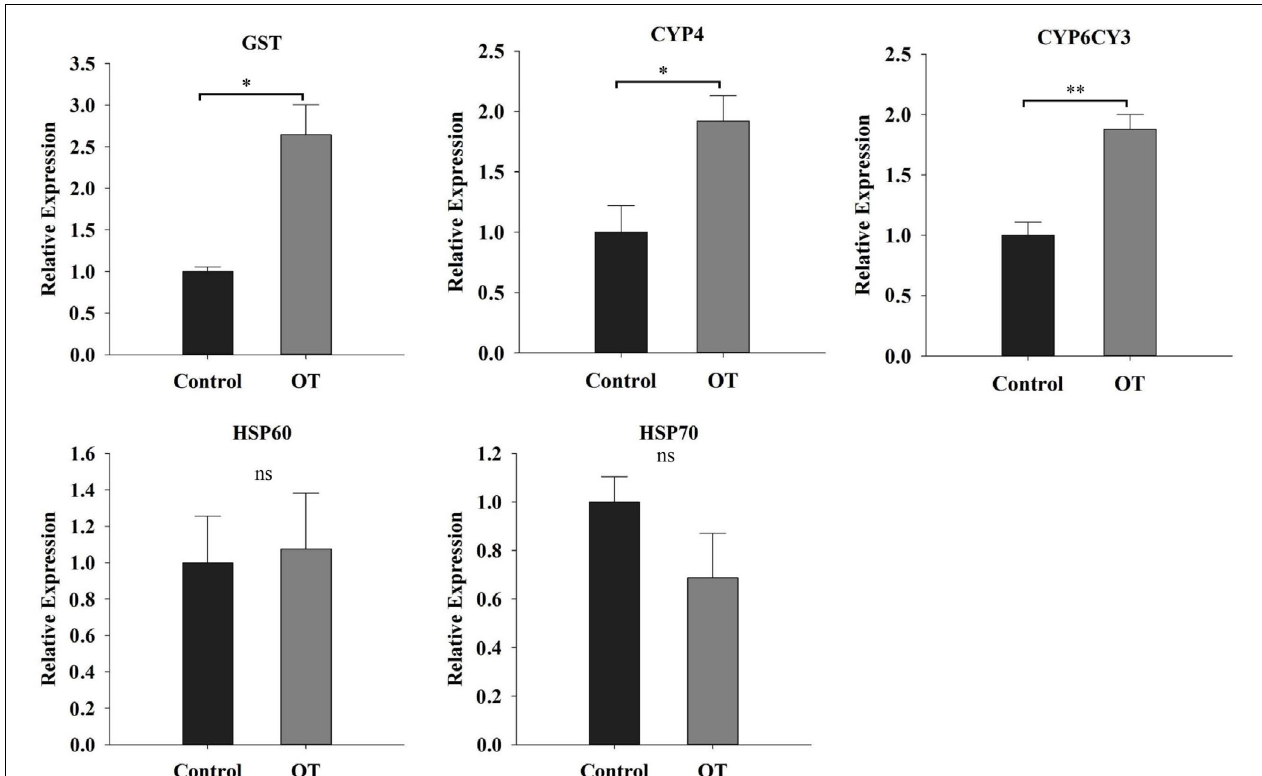
FIGURE 7 | The detoxify response of M. persicae reared on β -ocimene-treated and control Chinese cabbages. OT, β -ocimene treated Chinese cabbage. Different letters over the bars designate a significant difference: ∗ P < 0.05, ∗∗ P < 0.01, ∗∗∗ P <